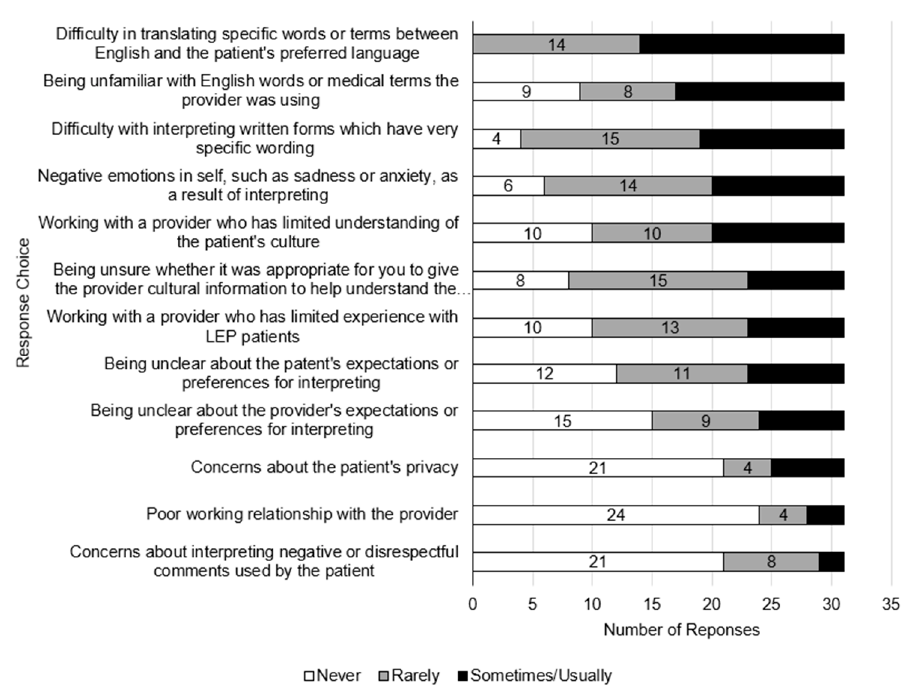
Figure 2. Communication challenges reported by interpreters. This figure illustrates how often each challenge was experienced by interpreters and corresponding frequency counts .